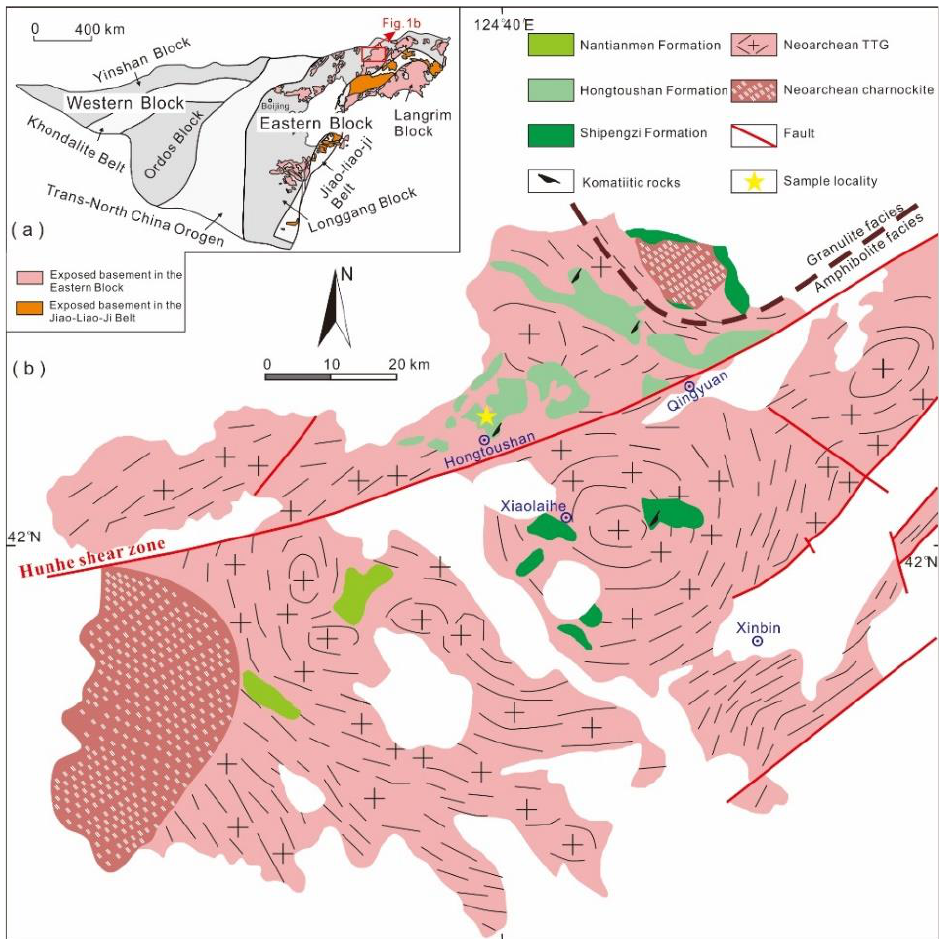
Figure 1. ( a ) Tectonic subdivision of the North China Craton (modified after [32,37]), showing the location of the Qingyuan area. ( b ) Geological sketch map of the Qingyuan area (modified after [25,27]), showing lithological distribution and sampling location.